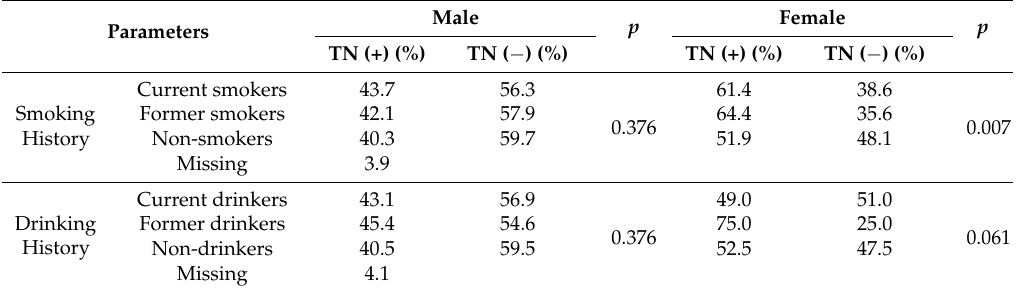
Table 3. Relationship of smoking and drinking to the prevalence of thyroid nodules stratified by gender.